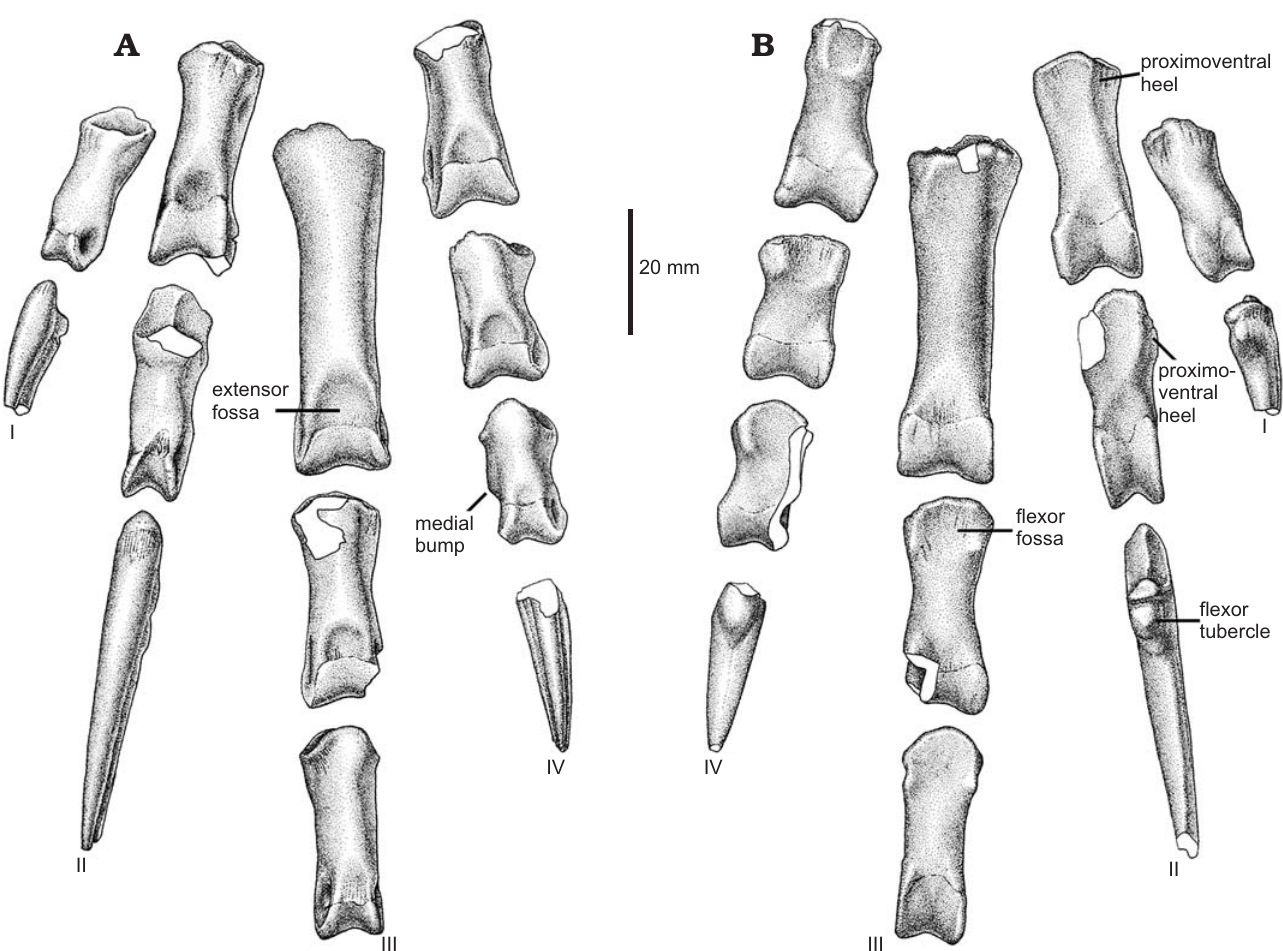
Fig. 8. Unenlagiid theropod Neuquenraptor argentinus Novas and Pol, 2005 (MCF PVPH 77) from Sierra del Portezuelo, Neuquén Province, Argentina; Portezuelo Formation, Coniacian, Late Cretaceous; left pedal phalanges in dorsal ( A ) and ventral ( B )